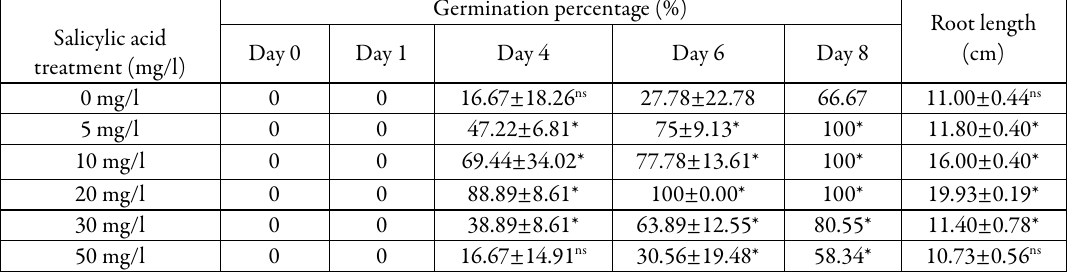
Germination percentage (%)